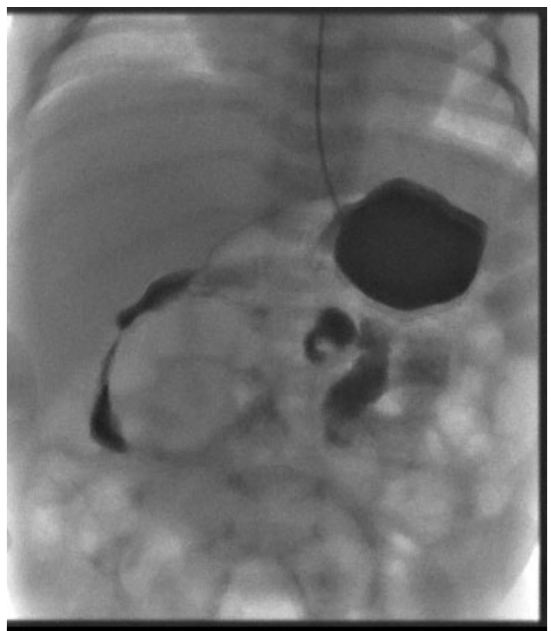
Fig. 1 Upper gastrointestinal contrast showing extrinsic mass dis- placing duodenum.